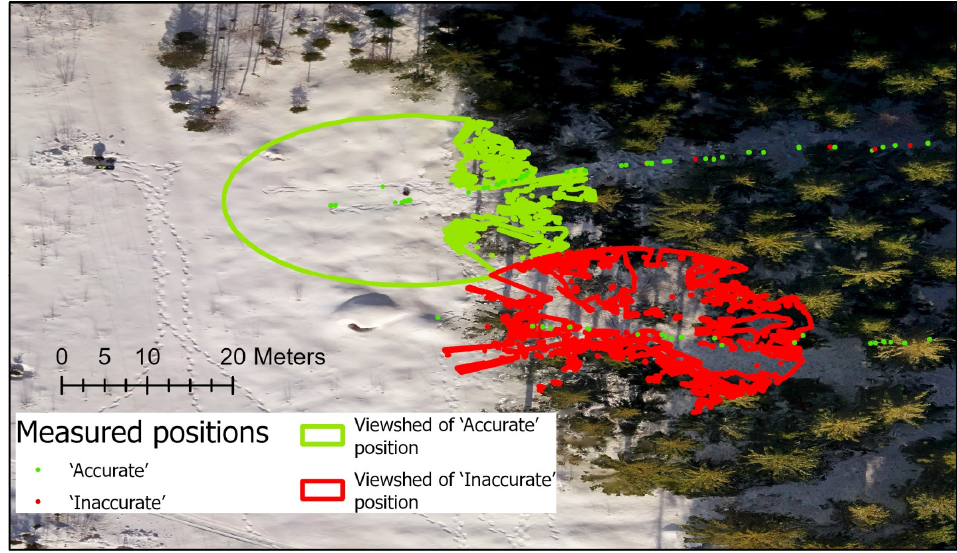
Figure 6. Examples of the viewshed analyses for ‘Accurate’ and ‘Inaccurate’ points. Table 4. The impact of canopy cover estimated from viewshed analysis of DSM for ‘Accurate’ and ‘Inaccurate’ positions.